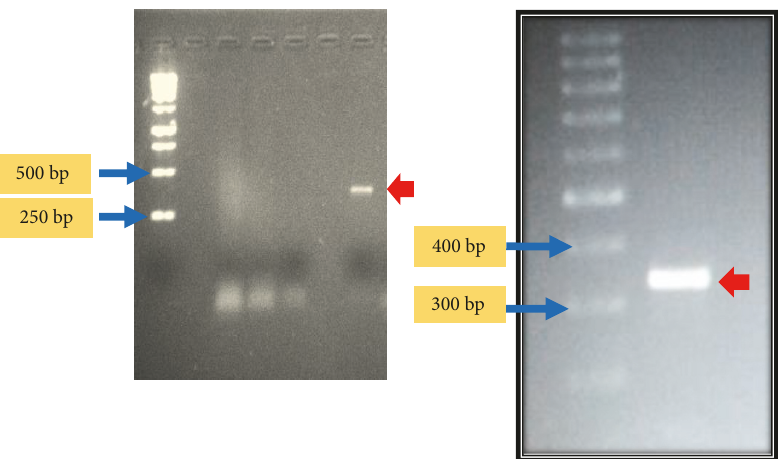
Figure 5: PCR amplification of nifH (left) and nifD (right) fragments using genomic DNA from Sub1 as template. The PCR amplicons of the correct sizes are indicated by red arrows.